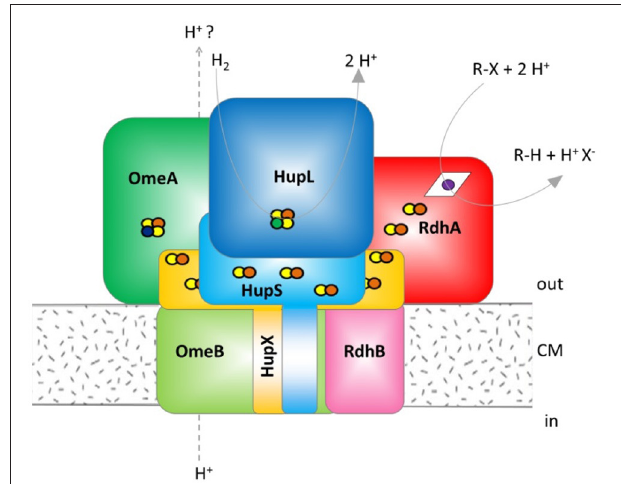
FIGURE 1 | Hypothetical model of the organohalide complex, modified from Kublik et al. (2016) representing multiple interactions between subunits. HupL, hydrogenase large subunit 48 kDa; HupS, hydrogenase small subunit 37.1 kDa, HupX, iron/sulfur protein 30.4 kDa, OmeA, organohalide respiration involved molybdoenzyme A 106 kDa; OmeB, organohalide respiration involved molybdoenzyme B 44.8 kDa; RdhA, reductive dehalogenase homologous protein active subunit ∼ 55 kDa; RdhB, reductive dehalogenase homologous anchoring protein B 11.2 kDa. The colors were defined ( Supplemental Table 2 ) and used throughout the manuscript for all graphs and tables. The yellow/red dots indicate Fe/S clusters, the blue dot indicates a molybdenum ion, the green dot a nickel ion and the violet dot a cobalt ion bound to a corrinoid.